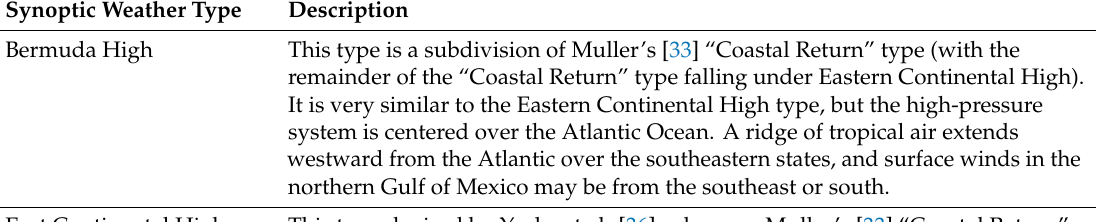
Table A1. Detailed descriptions of each synoptic weather type from Russell